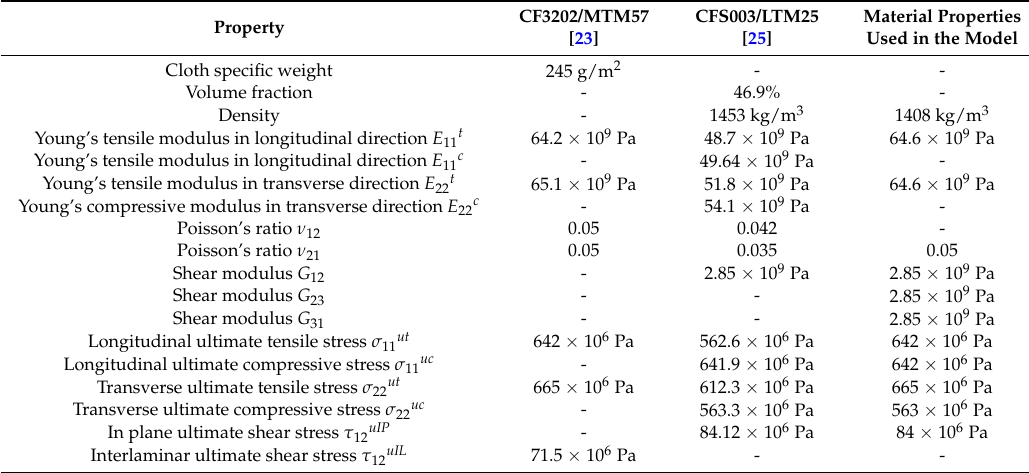
Table 2. Carbon-epoxy prepreg woven